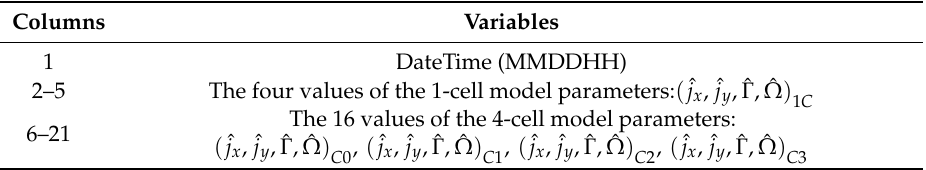
Table 1. Structure of the data matrix for the cluster